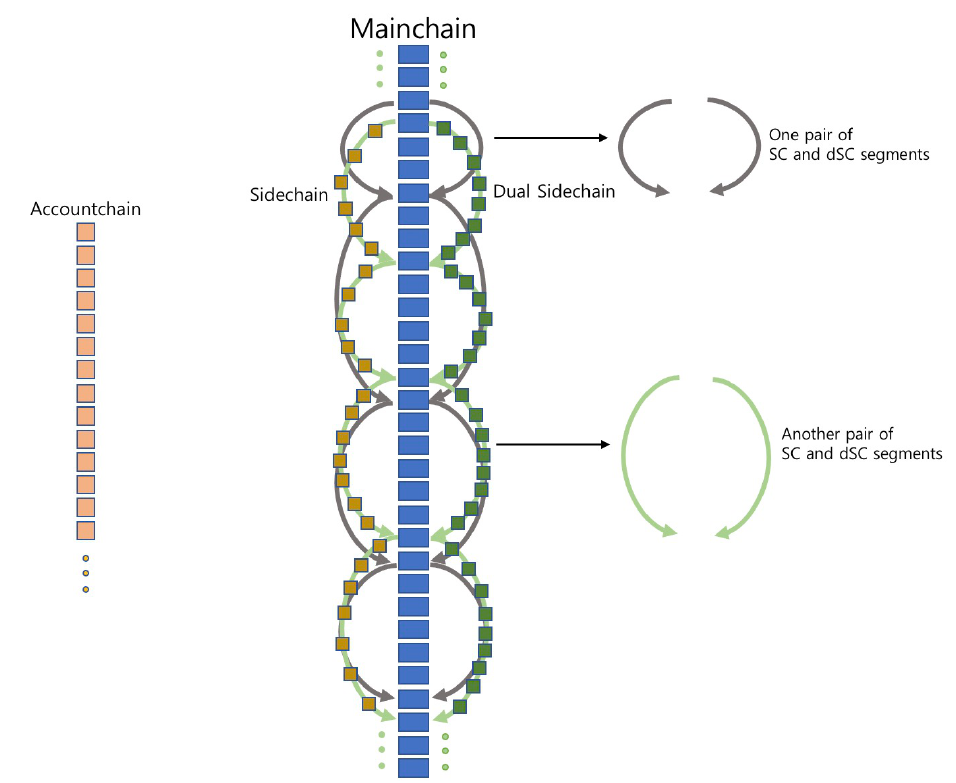
Figure 2. Components of the HMBS: MC, AC, SCs and